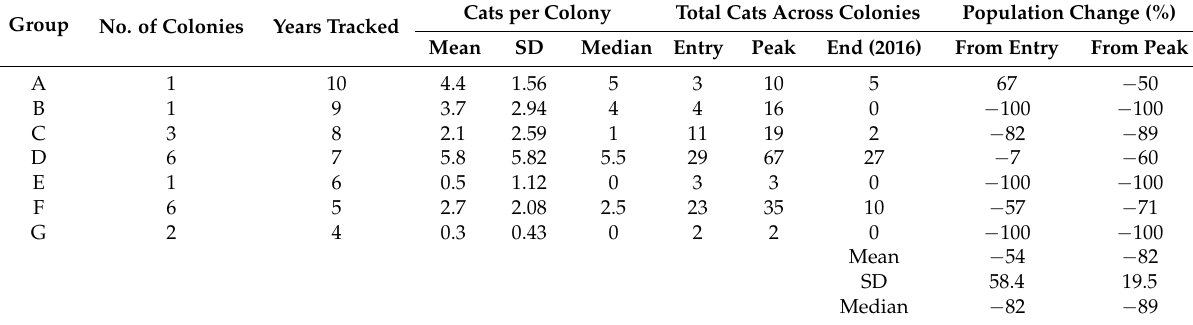
Table 5. Descriptive statistics for colonies, grouped by the number of years tracked. Mean, SD, and median are calculated using “entry” values as first-year